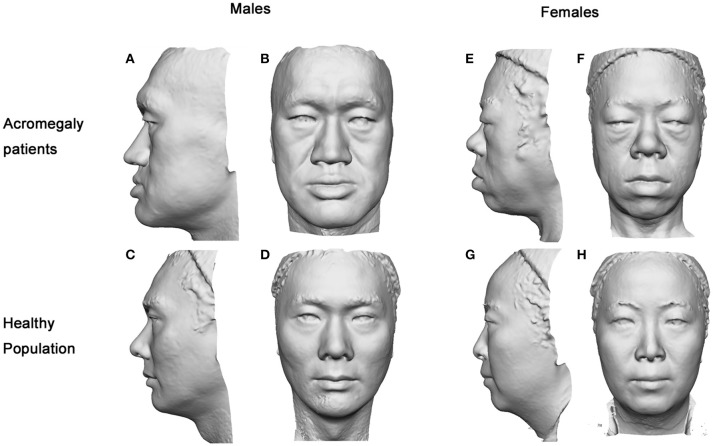
Gray-mode 3D images of the acromegaly patients and healthy controls. The facial characteristics of the acromegaly patients were remarkable as presented in either gender. In male patients (A,B), the nasofrontal angle and columella-labial angle were smaller, the gonion-gnathion distance was longer, the face contour and nose were larger, and the vermilions were thicker than those of the healthy males (C,D). In female patients (E,F), the face contour was more oval, the nose was wider, the nasofrontal angle was smaller, the gonion-gnathion distance was longer, and the vermilions were thicker than those of the healthy females (G,H).